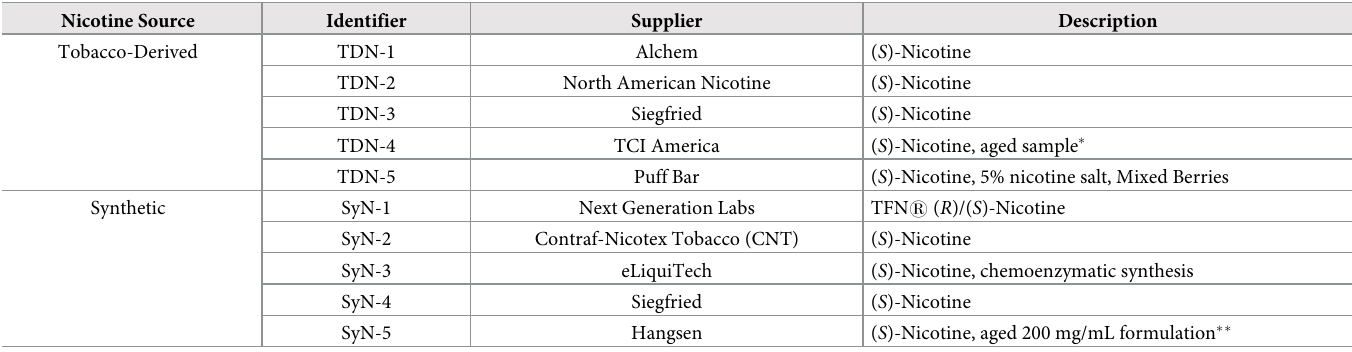
Table 1. Nicotine samples and e-liquid formulations